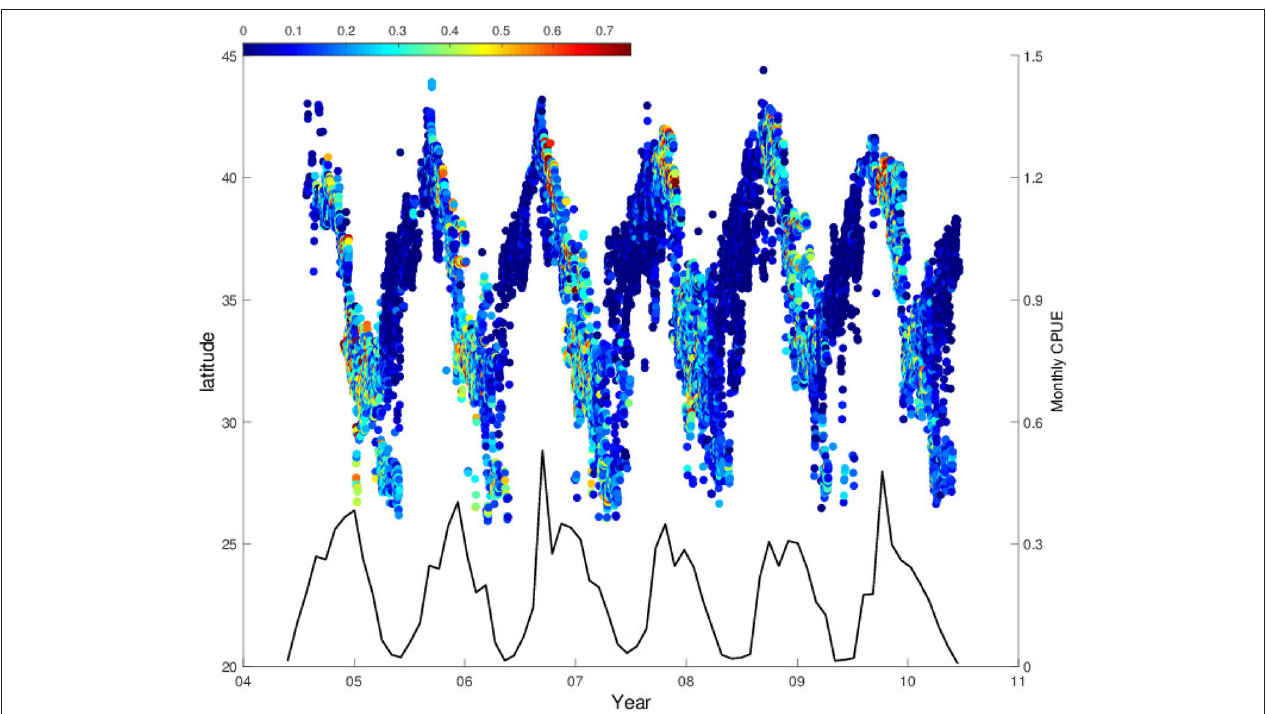
FIGURE 1 | Time series of daily average latitudinal fishing position with swordfish CPUE in color ( n / 100 hooks, where n is a number of catch) from 2004 to 2010 and the black line shows monthly